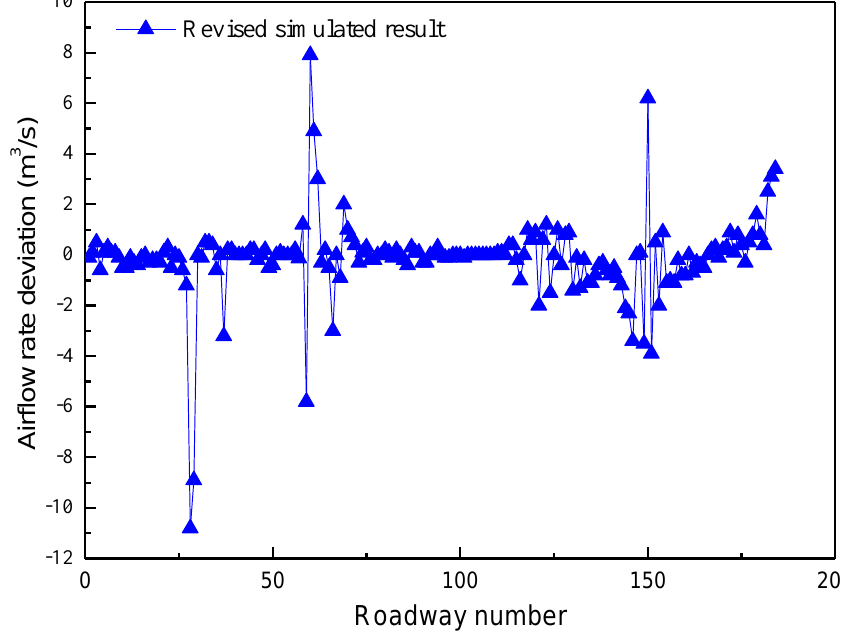
Figure 4. Deviation of calibrated simulated airflow rates.